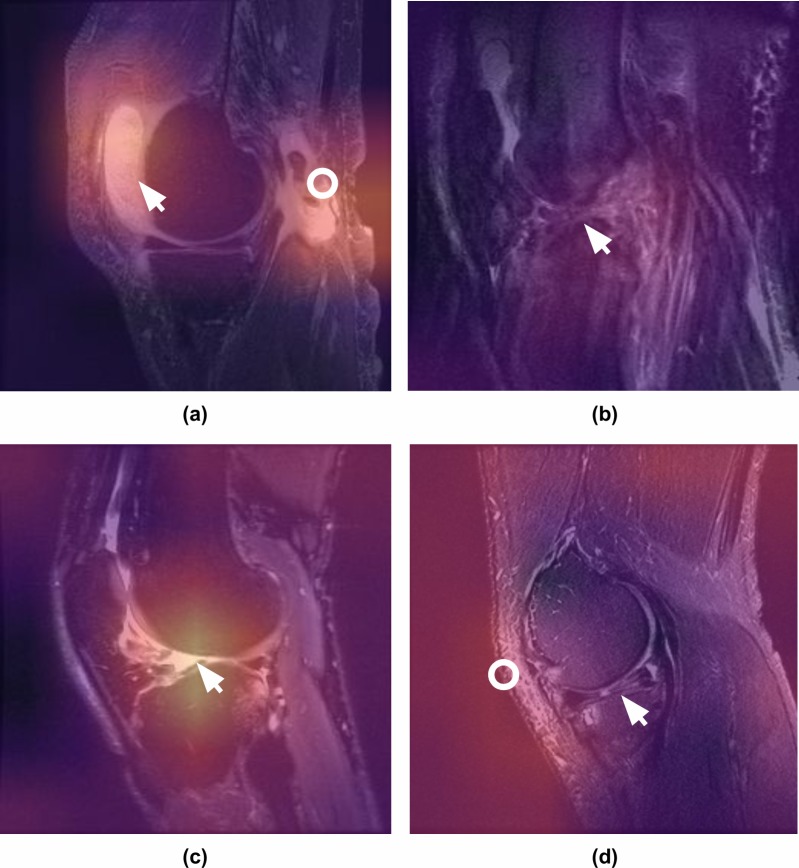
Class activation mappings for MRNet interpretation.Class activation mappings (CAMs) highlight which pixels in the images are important for the model’s classification decision. One of the board-certified musculoskeletal radiologists annotated the images (white arrows and circles) and provided the following captions. (a) Sagittal T2-weighted image of the knee demonstrating large effusion (arrow) and rupture of the gastrocnemius tendon (ring), which were correctly localized by the model and classified as abnormal. Note that the model was not specifically trained to detect these pathologies but was able to recognize the abnormalities based on the contrast with the normal knee examinations. (b) Sagittal T2-weighted image of the knee complicated by a significant motion artifact demonstrating complete anterior cruciate ligament (ACL) tear (arrow), which was correctly classified and localized by the model. Because we hoped to best approximate the clinical practice reality—in which the prevalence of artifacts (i.e. motion, metallic) and other technical noise disrupts interpretation of knee MRI—we did not exclude noisy cases from the training or validation data. (c) Sagittal T2-weighted image of the knee demonstrating complete disruption of the ACL, which was correctly identified by the model as abnormal and classified as ACL tear. The CAM indicates the focus of the model at the abnormal attachment of the ACL (arrow). (d) Sagittal T2-weighted image of the knee demonstrating a complex tear involving the posterior horn of the lateral meniscus (arrow). While the model did classify this examination as abnormal, the CAM indicates that the increased subcutaneous signal (ring) in the anterior/lateral soft tissues contributed to the decision but the meniscal tear did not.